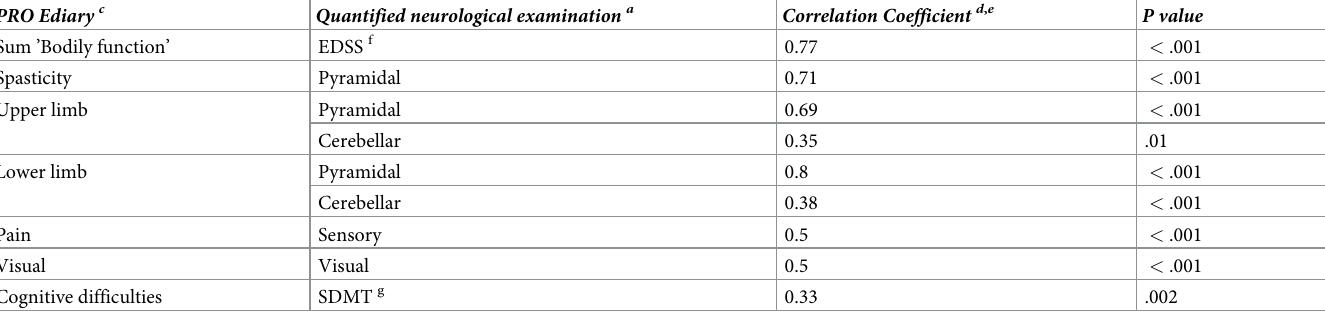
independent association with patients’ QoL. E-diary derived bodily function PROs were associated, tough not identical, with their corresponding domains from the quantified neu- rological examination, in support of their construct validity. Change in bodily function PROs over time on the group level was independently associated with clinical MS relapses, anxiety and depression. Table 3. Correlations between e-diary derived patient reported outcomes and quantified neurological examination scores at baseline. a,b PRO Ediary